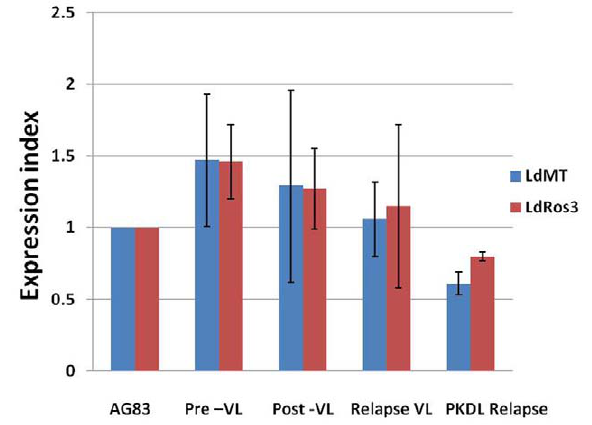
Figure 3. Expression of LdMT and LdRos3 in clinical isolates of VL and PKDL. Real-time reverse-transcription PCR expression analysis of L. donovani MIL transporter genes (LdMT and LdRos3) was performed using GAPDH as internal control. Graph shows the expression index, defined as ratio of gene expression relative to that of strain Ld AG83. Data represent the mean 6 SD of the results of three independent experiments.